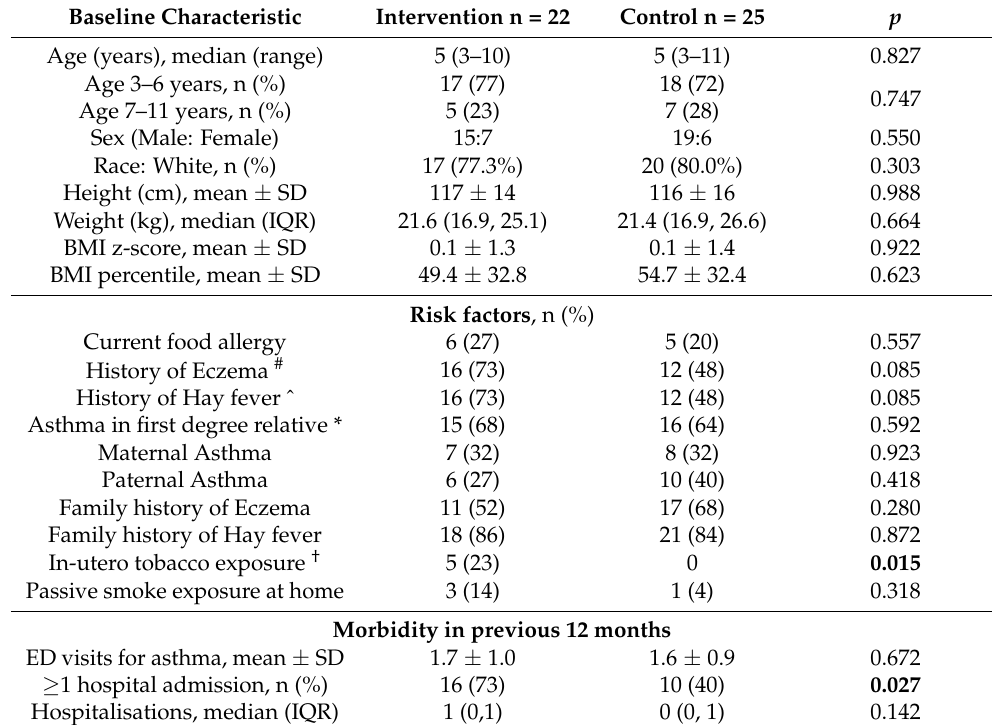
Table 1. Baseline demographics and clinical characteristics.